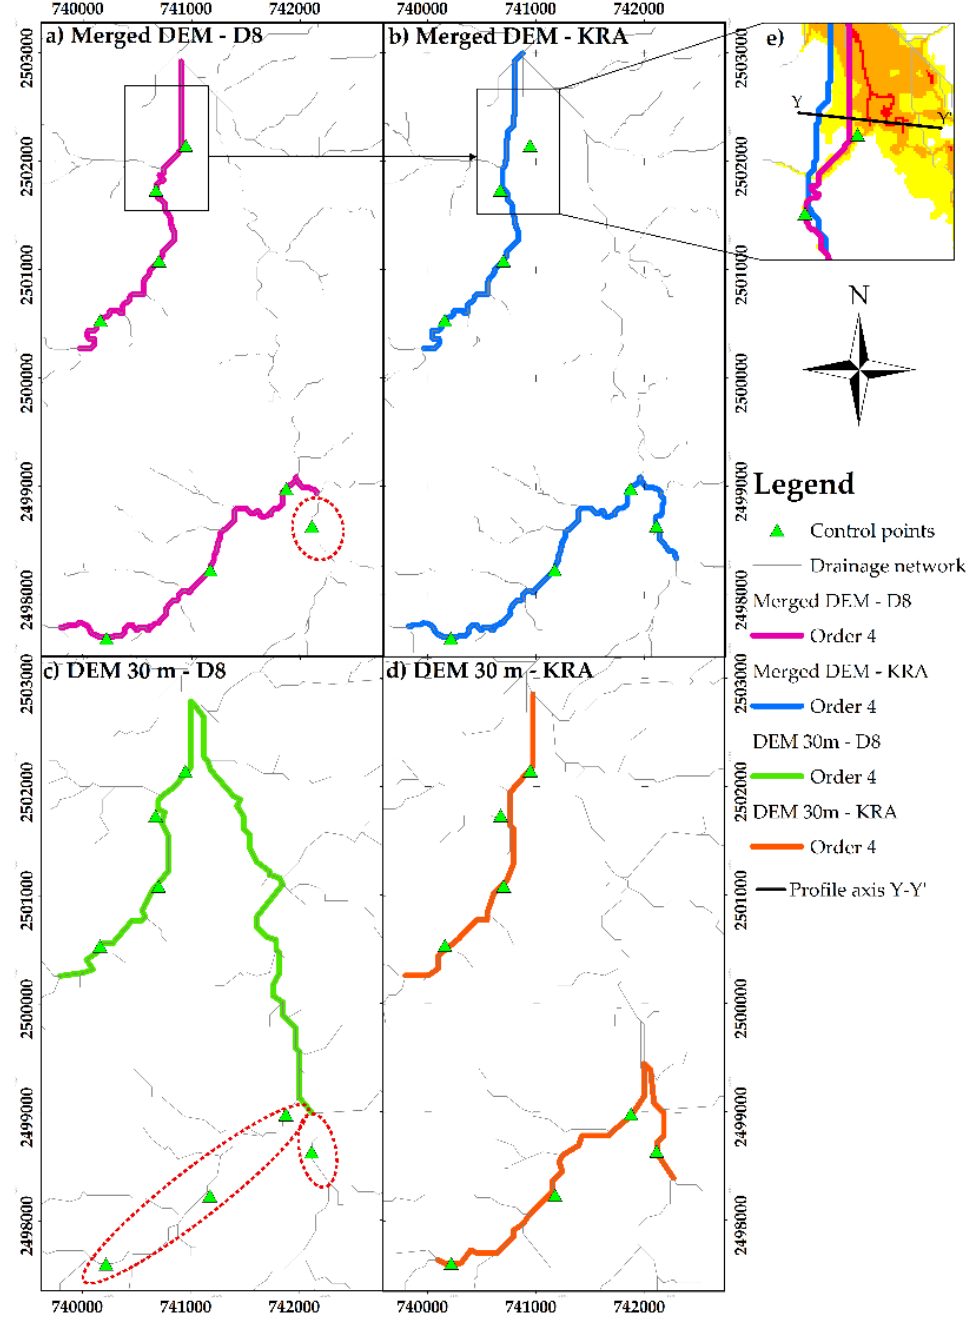
Figure 10. Drainage networks, control points, channels of stream order 4 and Y-Y’ axis over filled cells.